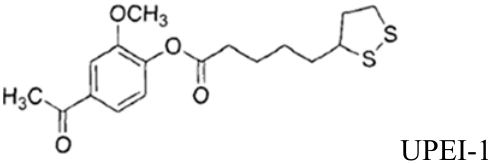
Figure 1. Summary of the synthetic method (including intermediate compounds; 1 and 2